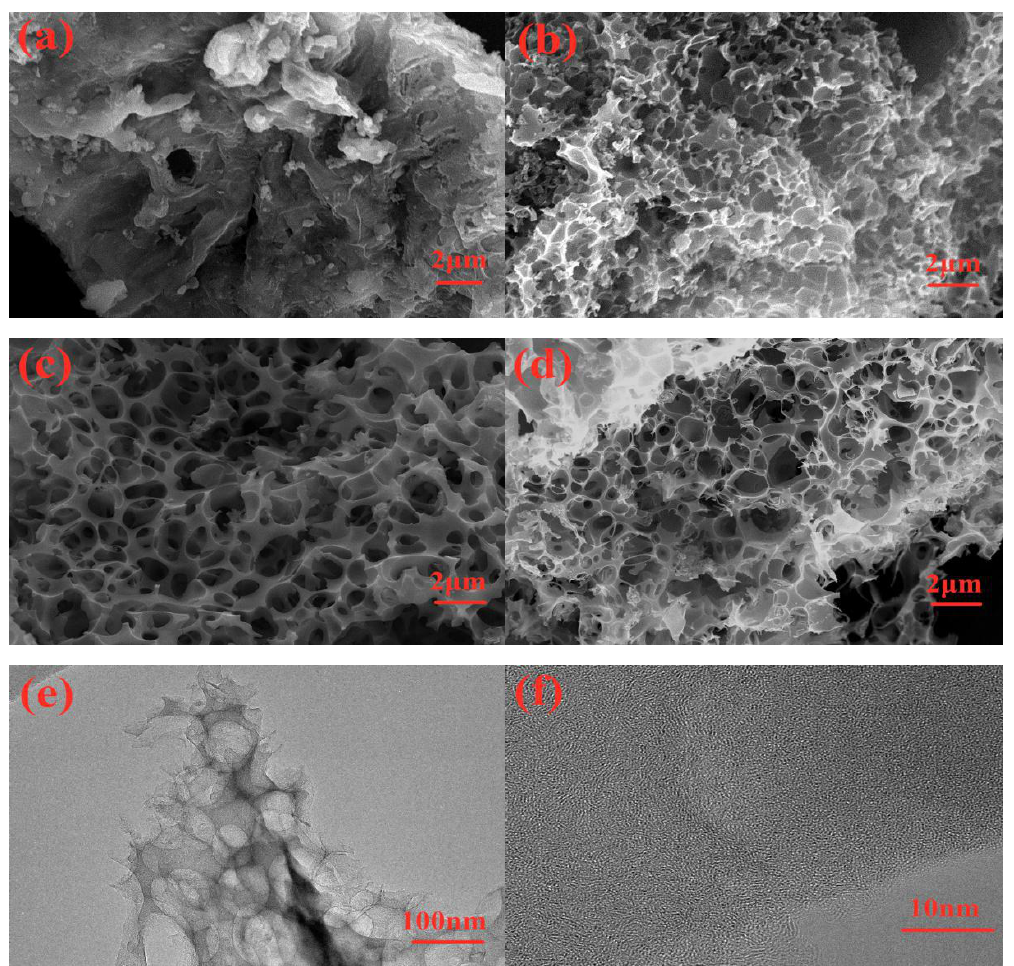
Figure 4. Scanning electron microscope (SEM) images of ( a ) C, ( b ) LSPC700, ( c ) LSPC800, and ( d ) LSPC900 at the same magnification; and ( e ) transmission electron microscope (TEM) and ( f ) HTEM (High voltage transmission electron microscope) images of LSPC800.